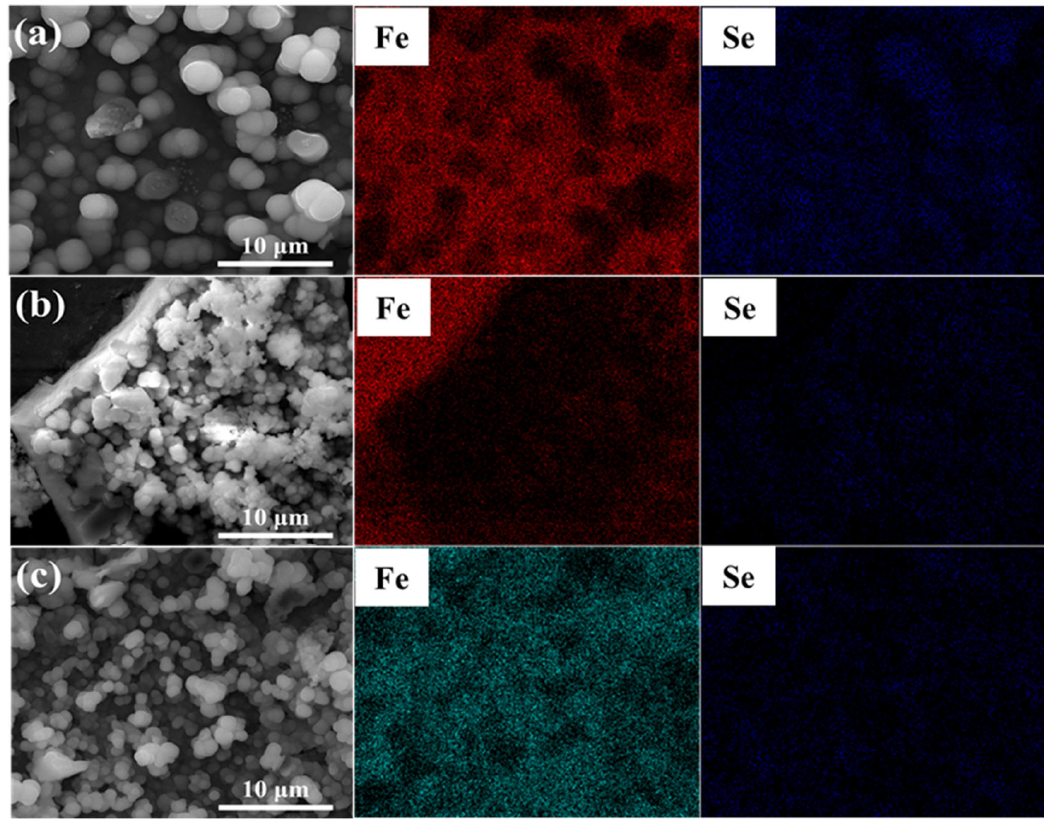
Figure 9. The EDS analysis of 304 stainless-steel samples after being treated by polarization measurements in different solutions and a 4 week immersion test in SG + Na 2 SeO 3 solution: ( a ) SG + CaCl 2 solution; ( b ) SG + Na 2 CO 3 solution; ( c ) SG + Na 2 SiO 3 solution.